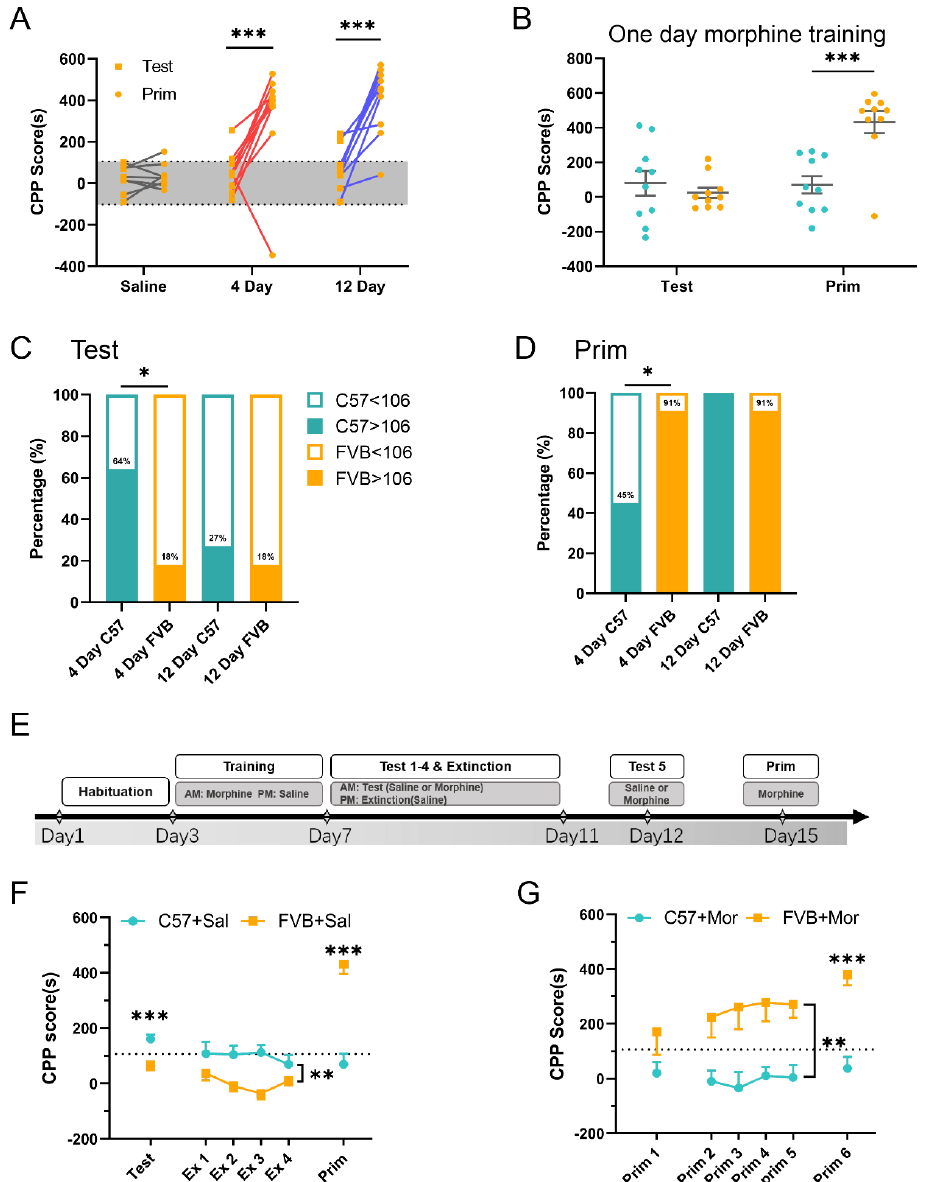
Figure 4. Relationship between weak learning ability and strong SUD susceptibility in FVB compared with C57 mice. ( A ). The effect of morphine training on the test and priming in FVB mice (n = 11, two-way ANOVA). Gray area range: 106 to − 102. ( B ). Comparison of the test and priming performance after morphine training for one day in C57 and FVB mice (n = 10, two-way ANOVA). ( C , D ). The percentage of CPP scores greater and less than 106 in the test and priming for morphine training for 4 days and 12 days between C57 and FVB mice (n = 11, chi-square test). ( E ). Experimental scheme. After 3 days of habitation, C57 mice and FVB mice underwent CPP training with morphine in the morning (am) and saline in the afternoon (pm) for 4 days and then underwent extinction trials for 4 days (for saline extinction, am: saline, pm: saline, ( F ); for morphine priming, am: morphine, pm: saline, ( G )). Low-dose morphine was then administered 3 days after extinction. CPP scores were determined by subtracting the times spent on the morphine training side each day. ( F ). The effect of saline on the extinction trials in C57 and FVB mice (n = 10, RM two-way ANOVA, t -test). The black line represents 106 s. ( G ). The effect of priming on saline extinction trials (n = 10, RM two-way ANOVA, t -test). * p < 0.05, ** p < 0.001, *** p < 0.001, Mean ±